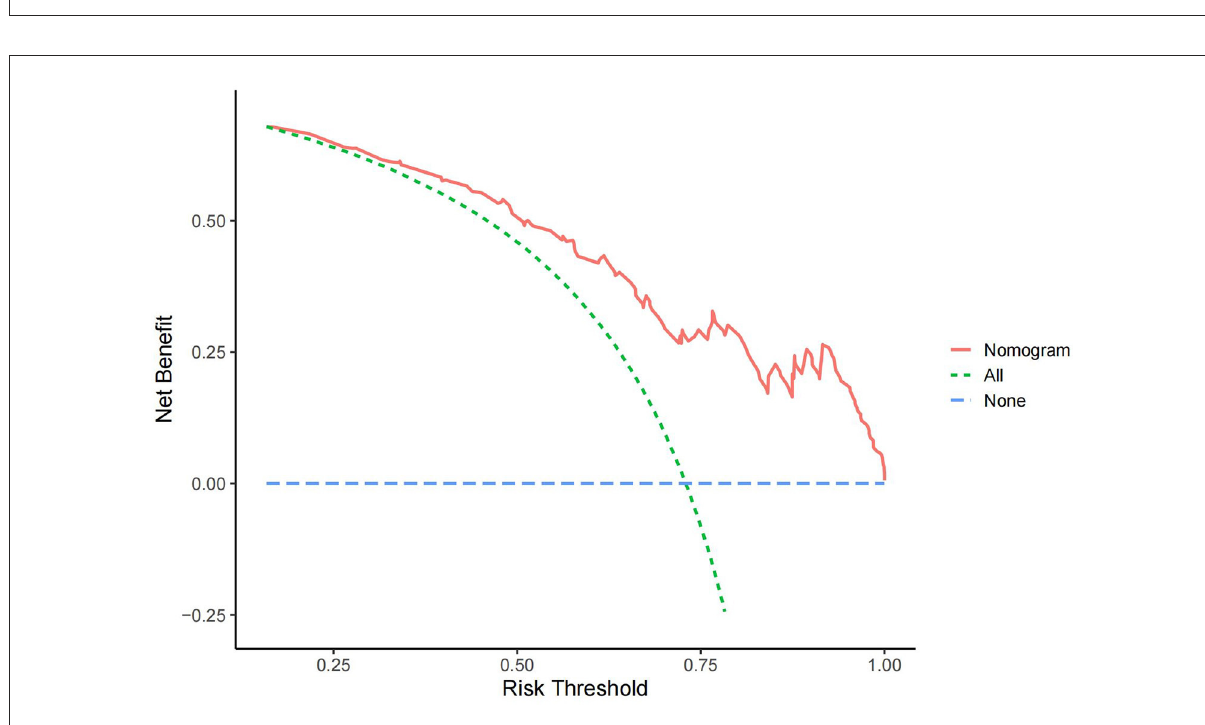
FIGURE4 DCA curve of the nomogram.